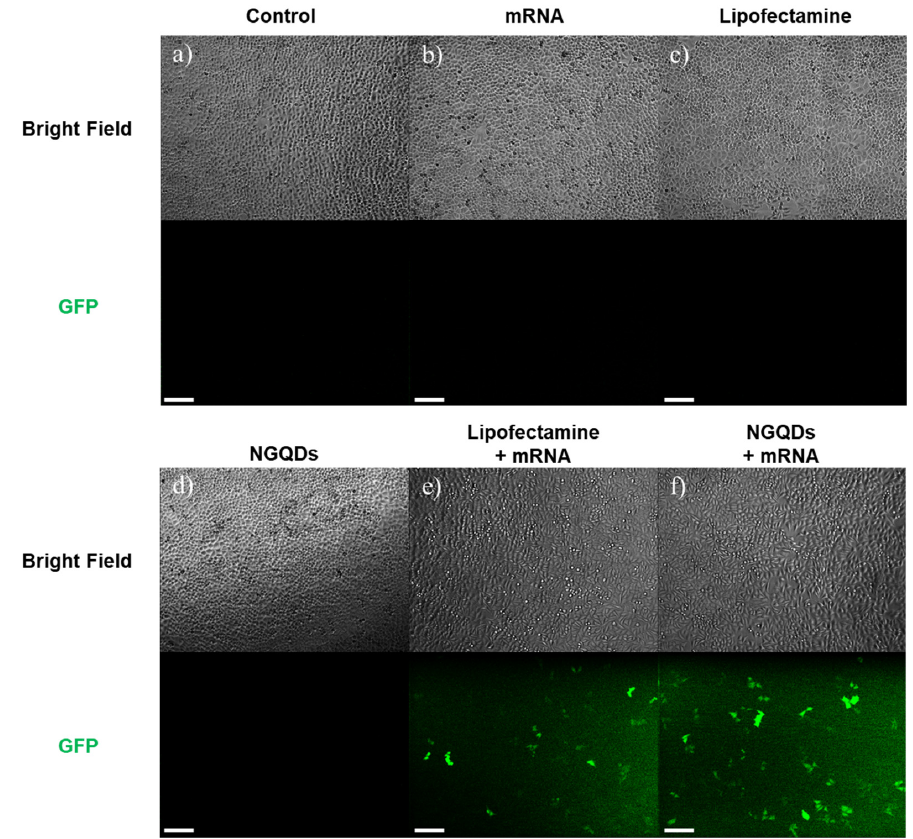
Figure 5. Fluorescence microscopy images of HeLa cells after 24 h transfection with ( a ) control (1 × PBS), ( b ) mRNA only, ( c ) Lipofectamine only, ( d ) NGQDs only, ( e ) Lipofectamine + mRNA complex, and ( f ) NGQDs + mRNA complex. All scale bars are 200 μ m.